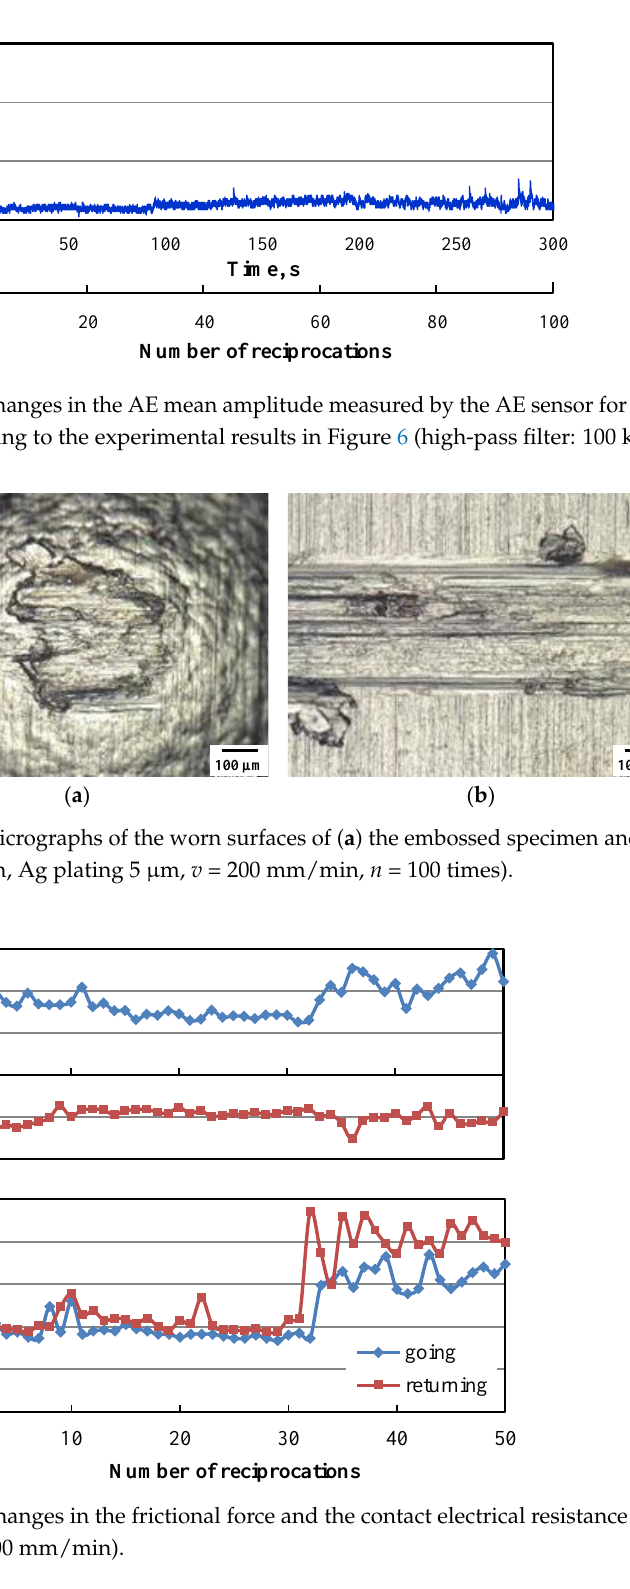
Figure 10. Changes in the AE mean amplitude measured by the AE sensor for the plate-specimen side, corresponding to the experimental data in Figure 9 (high-pass filter: 100 kHz). ( a ) ( b ) Figure 11. Micrographs of the worn surfaces of ( a ) the embossed specimen and ( b ) the plate speci- men (t = 0.2 mm, Ag plating 1 µm, v = 200 mm/min, n = 50 times). The transition point at around the 30th reciprocation, as shown in Figure 9, corre- sponds to the time position of 100 s in Figure 10. Therefore, the contact electrical resistance tends to change after the AE signal has changed. This is because AE sensing can capture microscopic wear processes. Even in experiments under different sliding conditions of normal load and sliding velocity, it was confirmed that the contact electrical resistance tended to increase after the burst-type AE signal was temporarily activated. This change